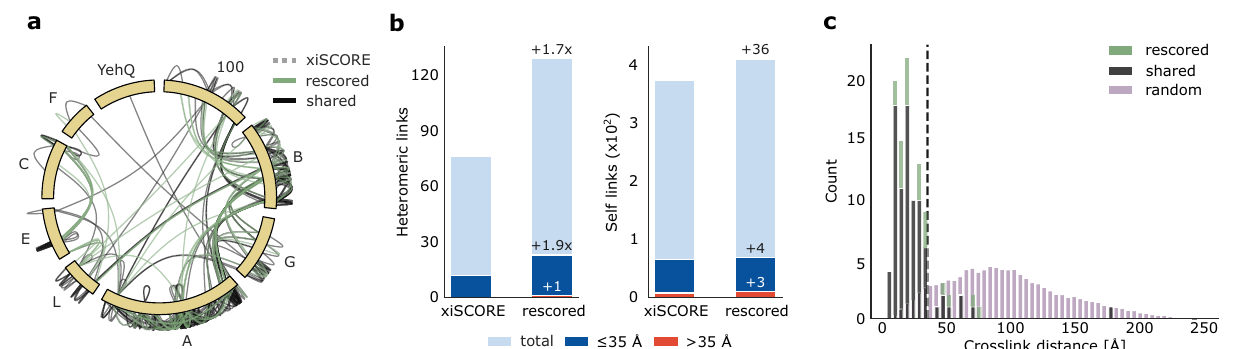
Fig. 5 Bene fi t of RT prediction for multiprotein complex crosslink analysis. a Crosslink network from the Fanconi anemia complex analysis, shown in the circular view. Unique residue pairs from xiSCORE (gray), after rescoring (green), and shared (black) between these analyses are depicted (1% residue-pair FDR). Proteins associated to the Fanconi anemia core complex are indicated with their gene name suf fi x. The E. coli protein YehQ represents a match from the entrapment database. b Quantitative assessment of residue-pairs with and without rescoring, and including calculated distances in the model (all, light blue; ≤ 35 Å, blue; >35 Å red). c Distribution of crosslink distances from identi fi ed residue-pairs ( n = 105) following rescoring (green), shared (black) between rescoring and xiSCORE (since no crosslinks unique to xiSCORE), and theoretically possible residue-pairs (random) that could be mapped to the model. Source data are provided as a Source Data fi second chromatographic dimension by hydrophilic strong anion exchange chro- matography (hSAX). Here, we used a Dionex IonPac AS-24 hSAX column (250 × 2.0mm) with an AG-24 guard column (Thermo Fisher Scienti fi c, Dreieich, Ger- many) running at 0.15 ml/min on an Äkta pure system (see above) and at 15 °C. rated under isocratic conditions for 3min, followed by elution using an exponential gradient: 1.8, 3.5, 5.3, 7.1, 9.1, 11.2, 13.5, 16.3, 19.7, 24.1, 30.2, 38.8, 51.5, 70.6, 100%